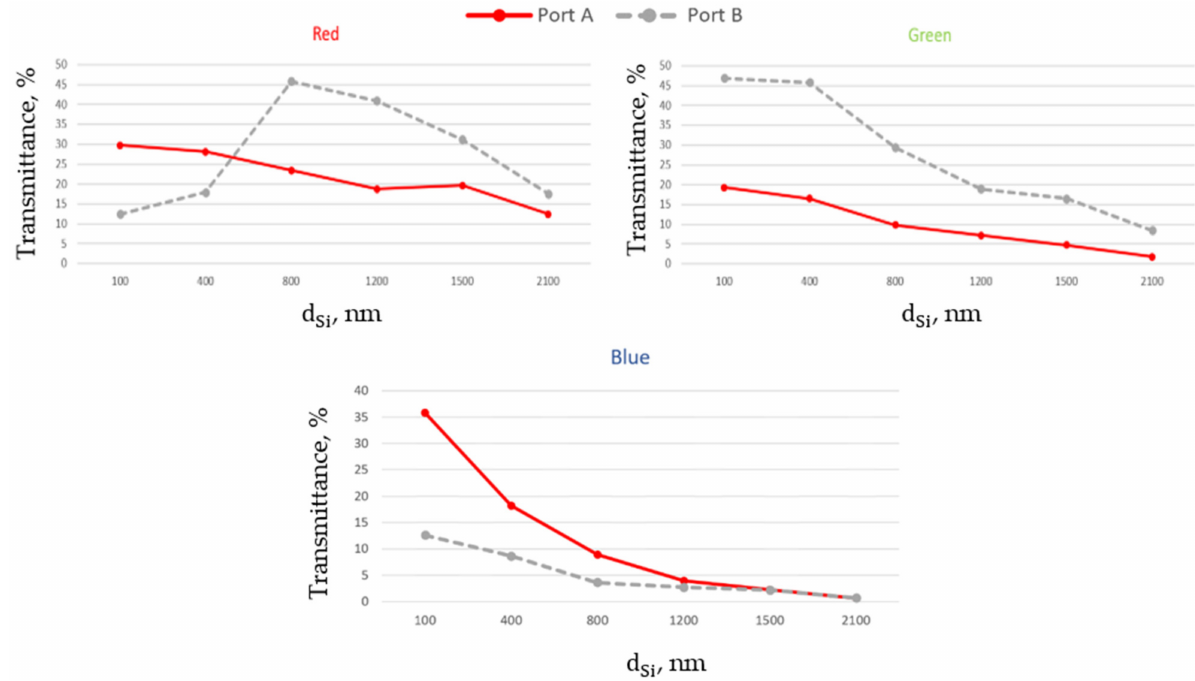
Figure 7. Total transmittance measured for three different RGB colors as a function of the distance between the deep-trenches at normal incidence and d ARC = 200 nm, d DT = 100 nm, W ∗ = 360 nm for inclined incidence α = 15 ◦